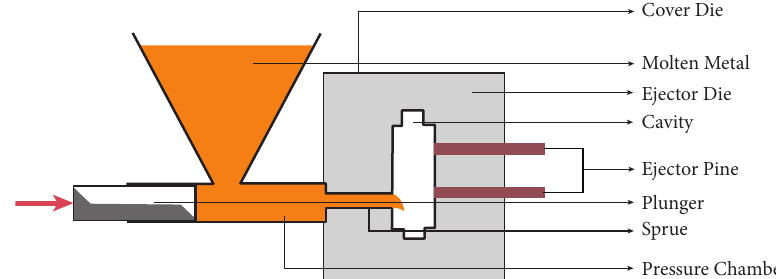
Figure 4: Schematic representation of die casting.